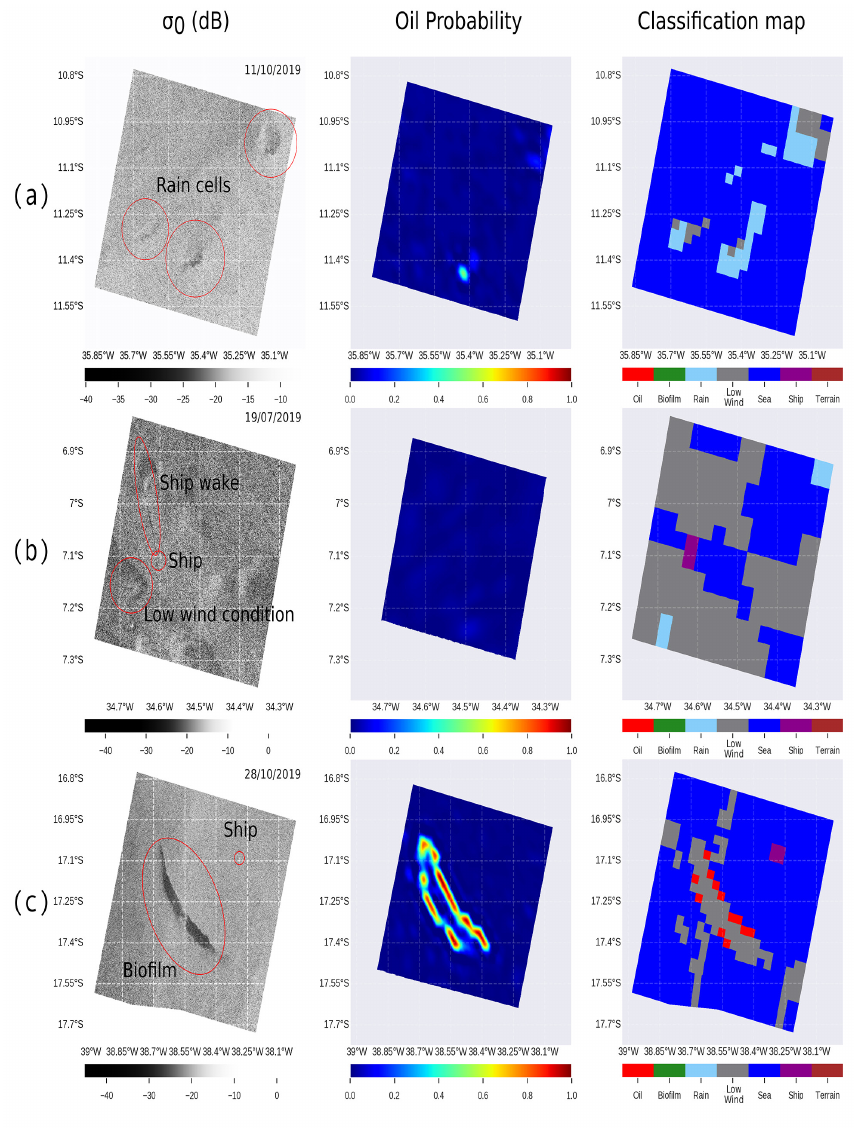
Figure 5. Oil probability and target classification maps based on the three SAR image case studies as outputs